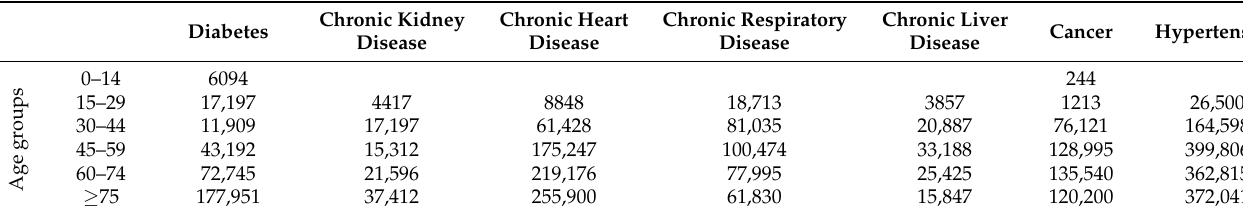
Table A4. Absolute frequencies of individuals with risk factors for increased risk of severe COVID-19 [28,45,47].